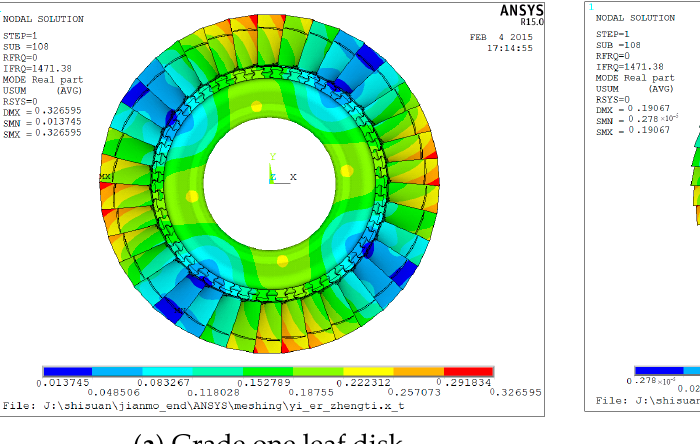
Figure 30. Mode 99 × 10 − 5 × 10 − 4 × 10 − 3 . Figure 30. Mode 99.